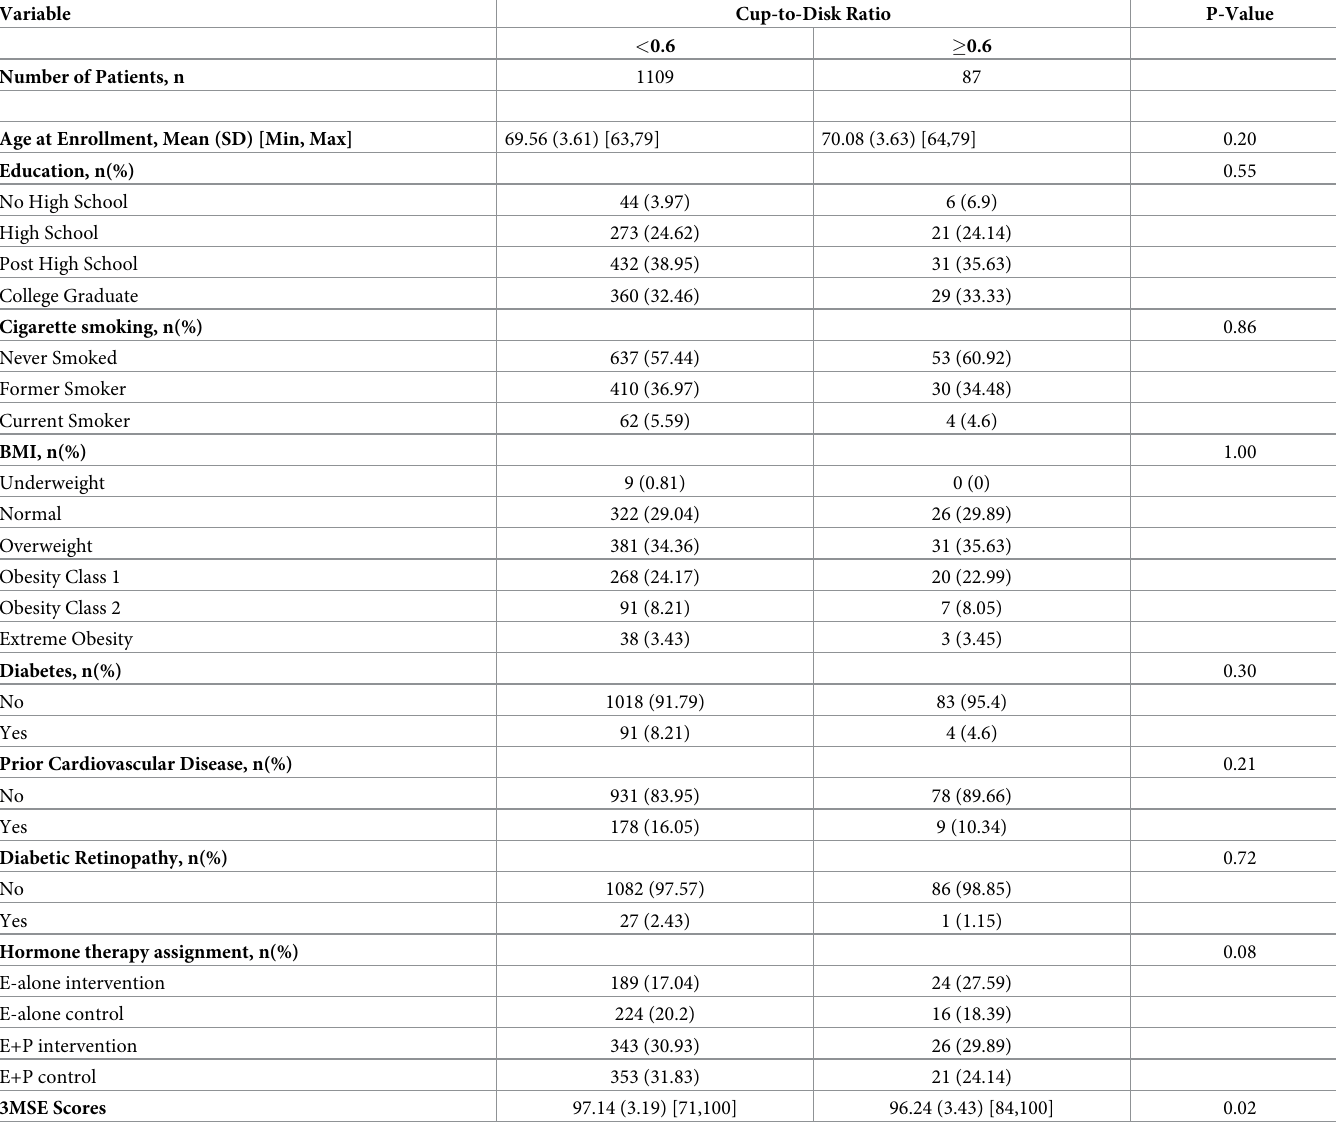
Table 3. Patient demographic and clinical characteristics by large cup-to-disk ratio. Variable Cup-to-Disk Ratio P-Value < 0.6 �